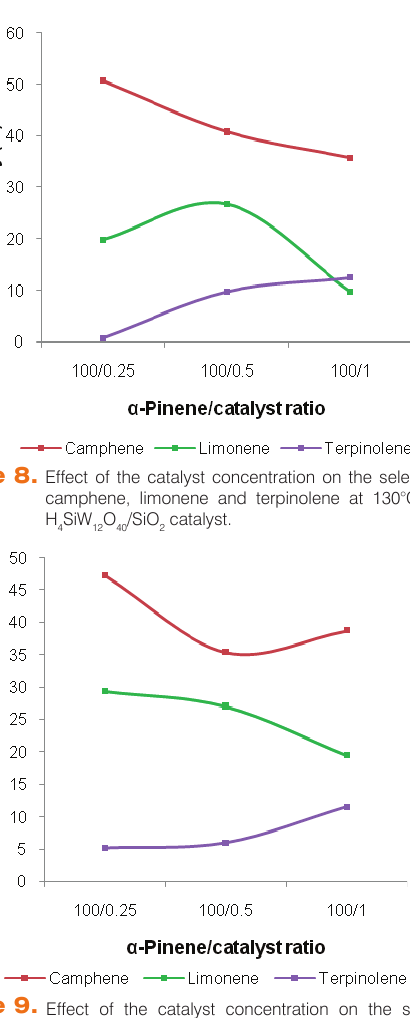
Figure 9. Effect of the catalyst concentration on the selectivity to